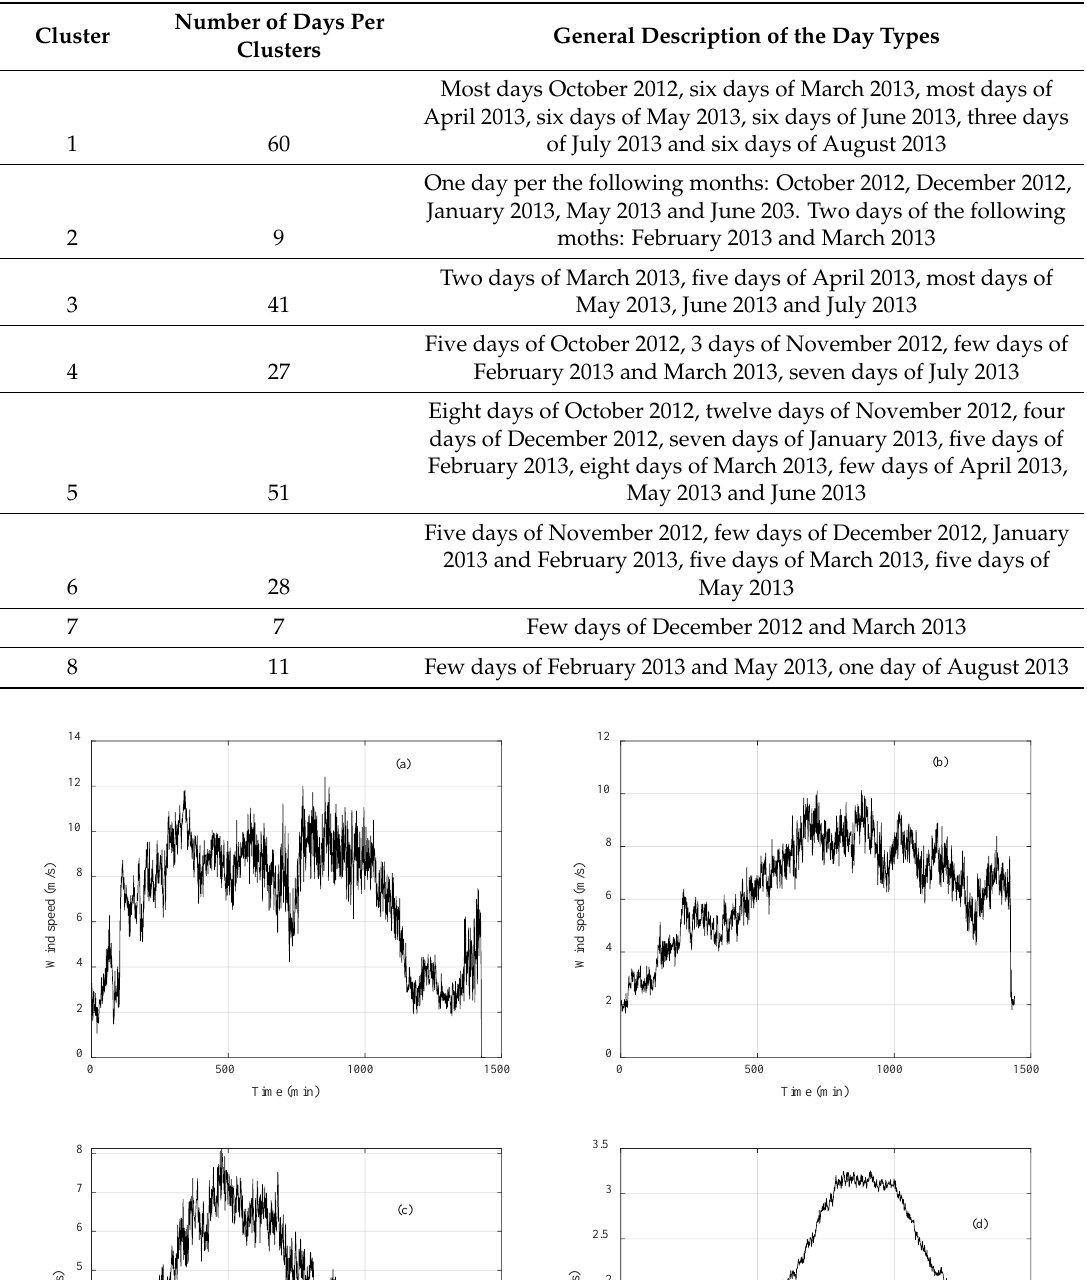
Table 2. Number of days and day types per cluster. The clustering was held with the K-means algorithm.